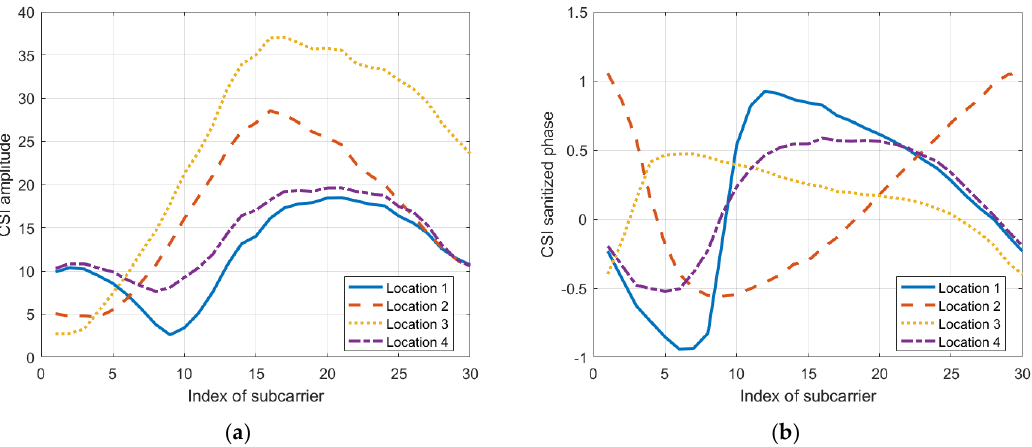
Figure 5. The mean vectors of a communication link tested at 4 locations for ( a ) the CSI amplitude and ( b ) the CSI sanitized phase.